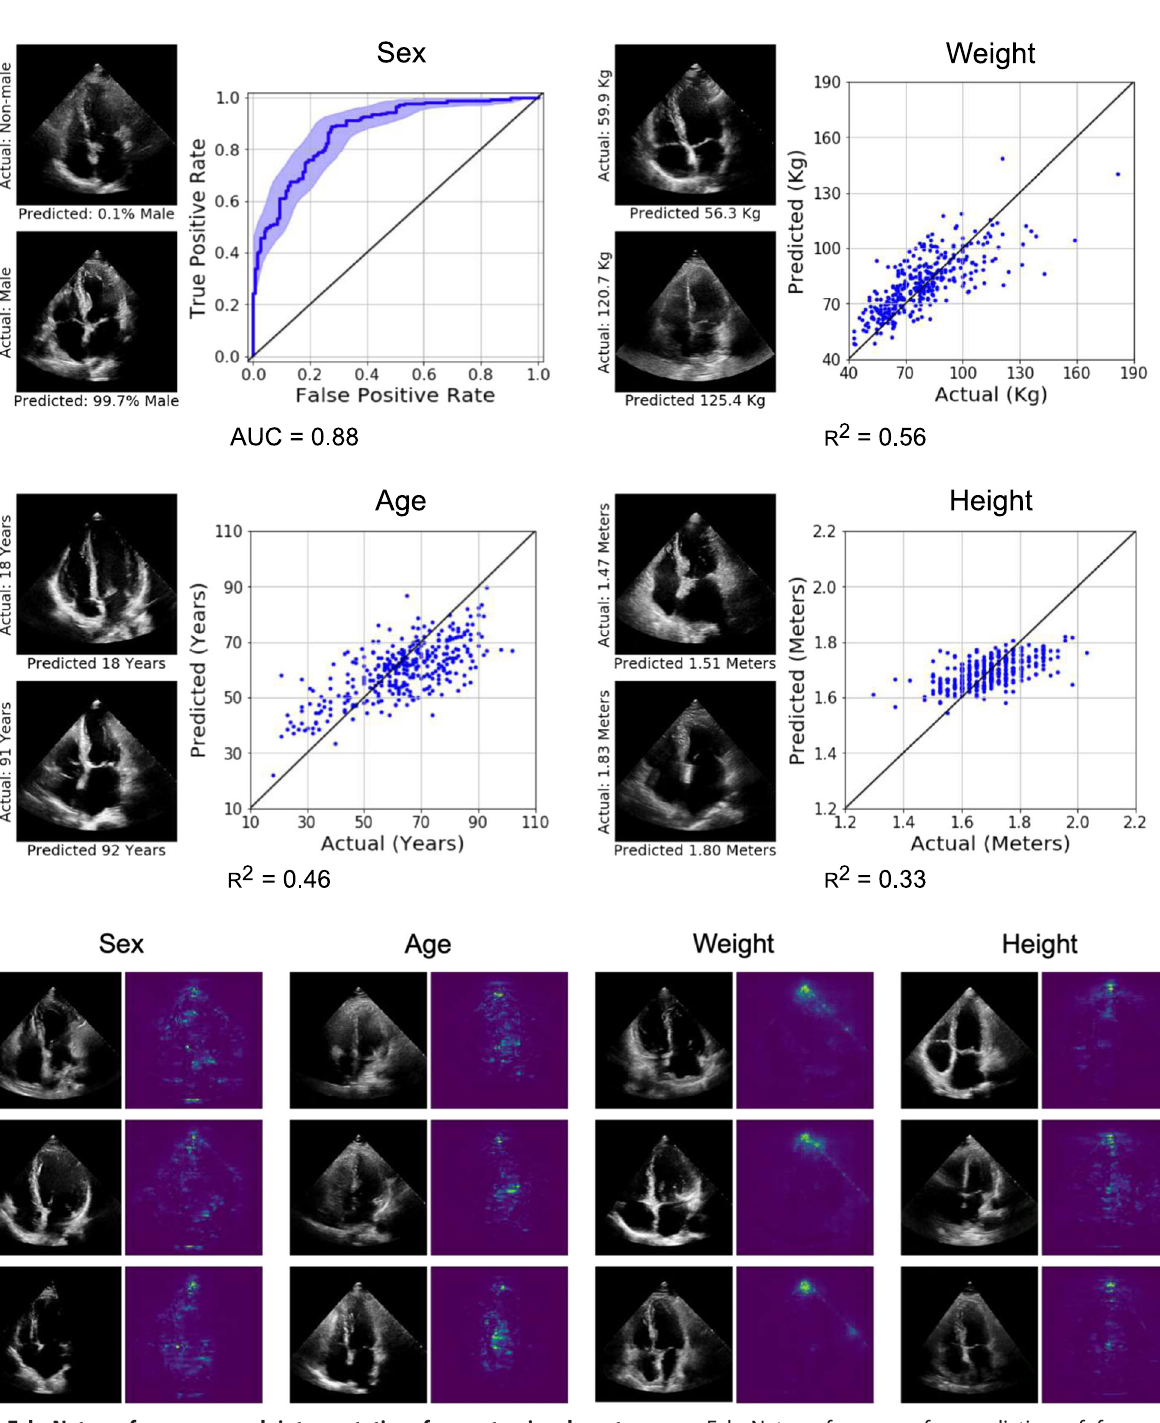
Fig. 4 EchoNet performance and interpretation for systemic phenotypes. a EchoNet performance for prediction of four systemic phenotypes (sex, weight, height and age) using apical-4-chamber view images. Shaded areas indicate 95% con fi dence intervals. b Interpretation of systemic phenotype models with representative positive examples shown side-by-side with regions of the same institution. Our approach trains deep learning models detailed measurements or localizations. In the development of on previous studies and associated annotations from the EMR to any machine learning models to healthcare questions, external leverage past data for rapid deployment of machine learning validity of fi rst-order importance. An important caveat of our models. This approach leverages two advantages of echocardio- work is that the images obtained were from one type of graphy, fi rst that echocardiography is one of the most frequently ultrasound machine and our test dataset was of different using imaging studies in the United States 42 and second, patients but also scanned using the sample machine and at